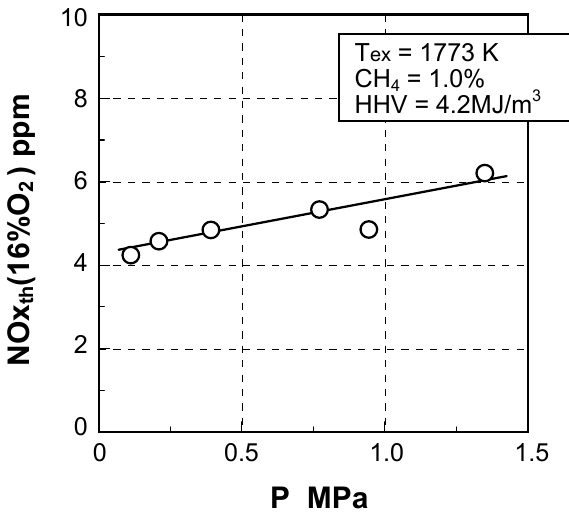
Figure 54. Influence of pressure inside combustor on thermal NOx emission characteristics at rated load